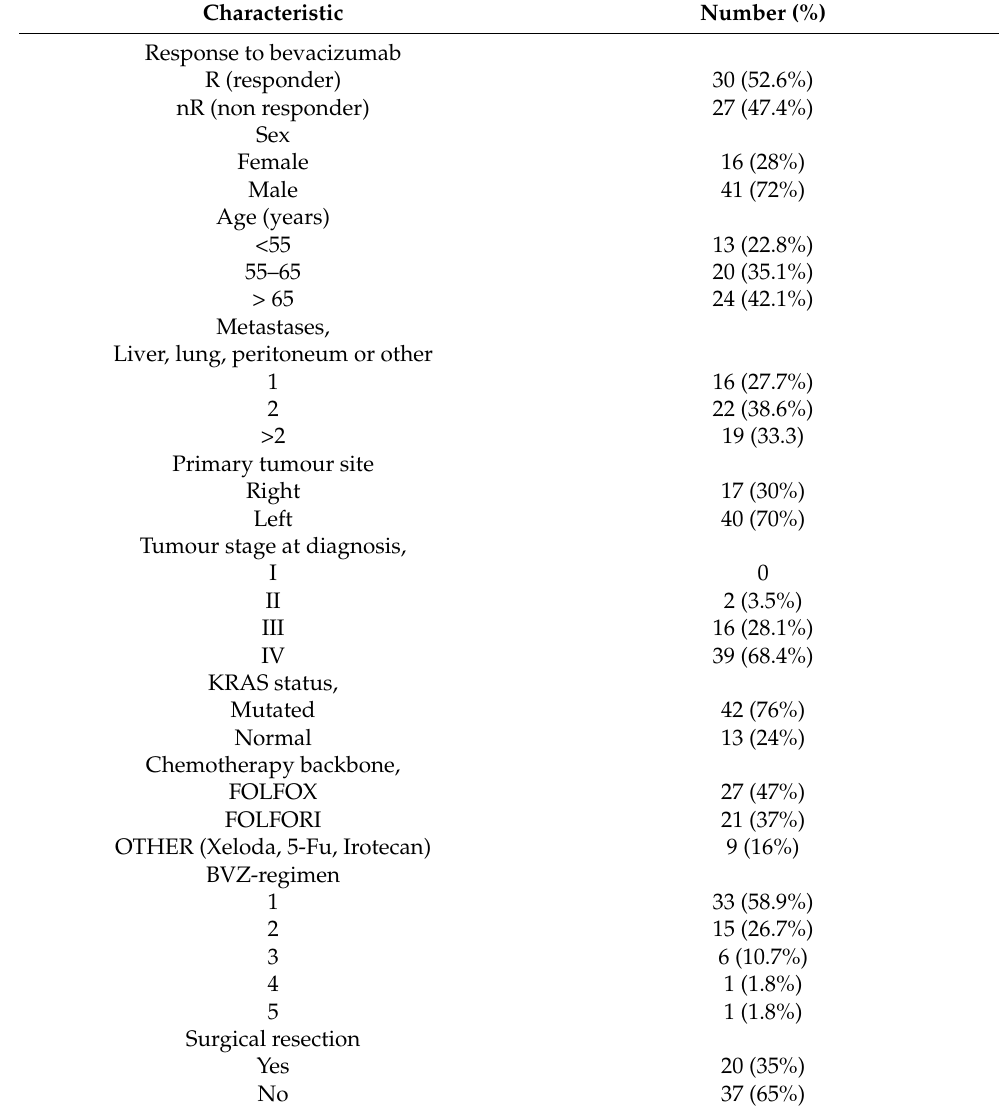
Table 1. Patient characteristics (n =